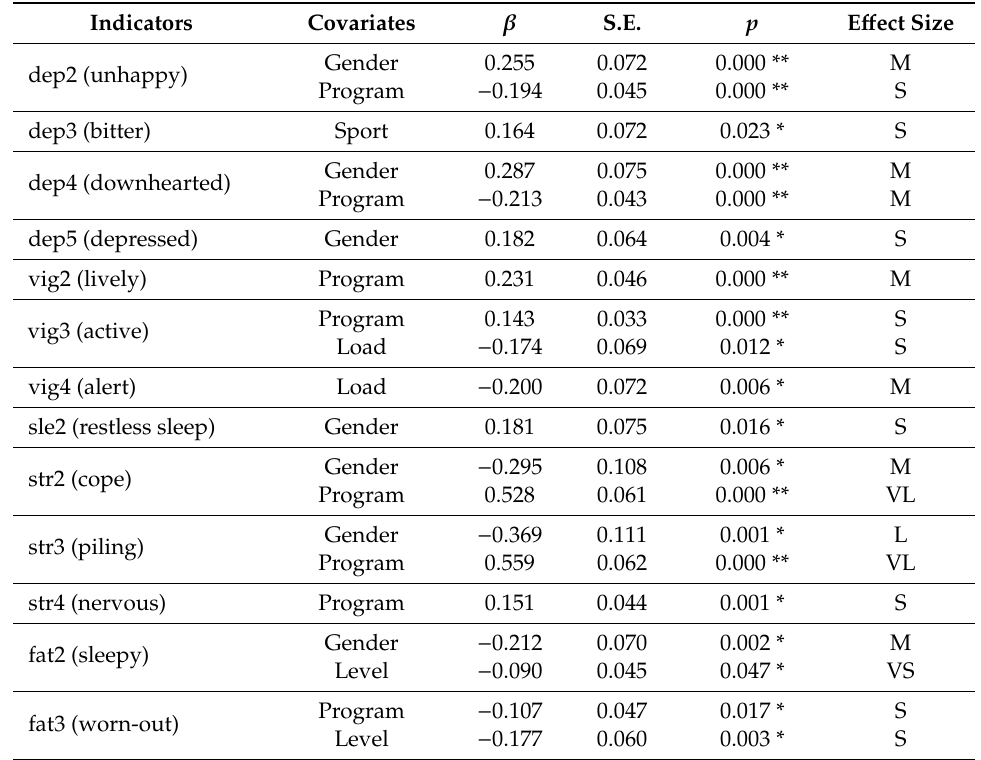
Table 11. Standardized (STD) model results for the MIMIC model testing DIF with the interpretation of e ff ect